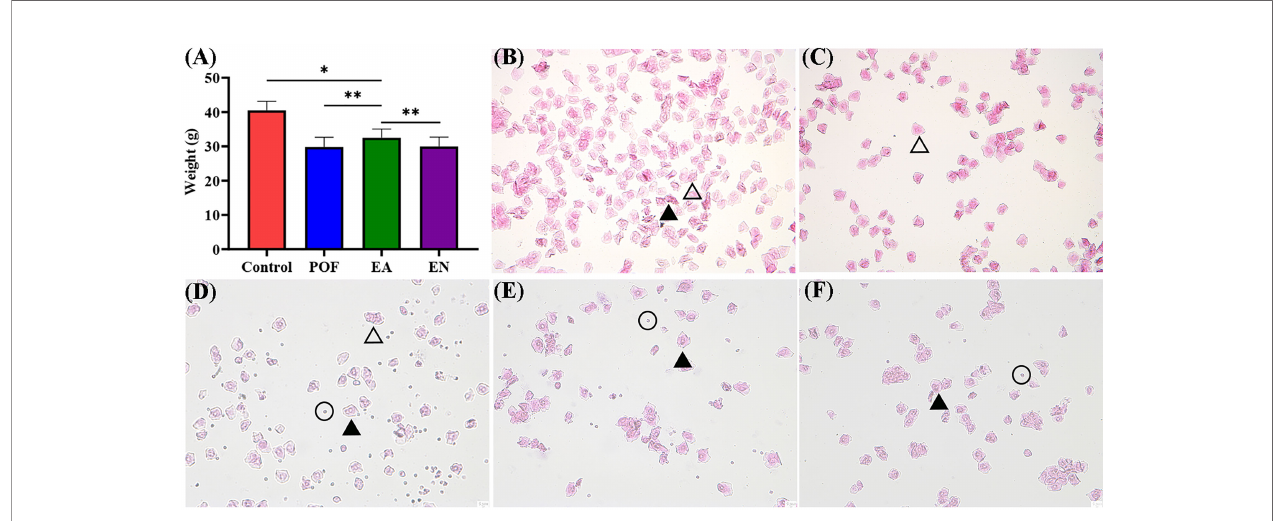
FIGURE 2 | The weight of four groups (A) , and the typical morphology of vaginal exfoliated cells in each estrous cycle (B) , proestrus; (C), estrus; (D) , metestrus; (E) , diestrus; (F) , POF model; ×40 magni fi cation) (* means P < 0.05; ** means P <